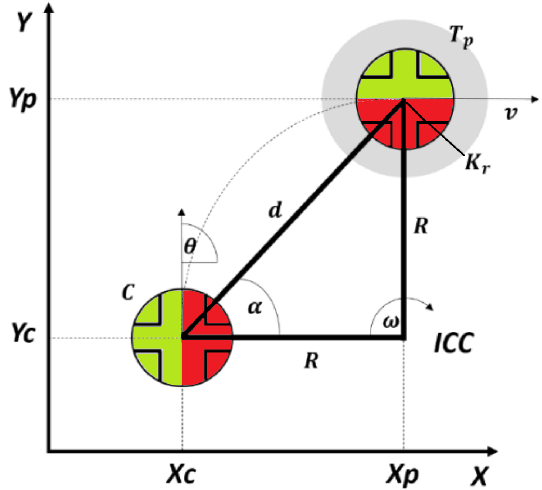
Figure 7. Position control geometry, from